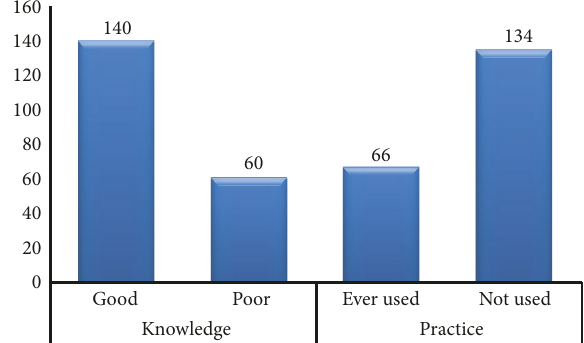
Figure 2: Frequency distribution of knowledge and practice of emergency contraceptive among female college graduating students of Harar, eastern Ethiopia,